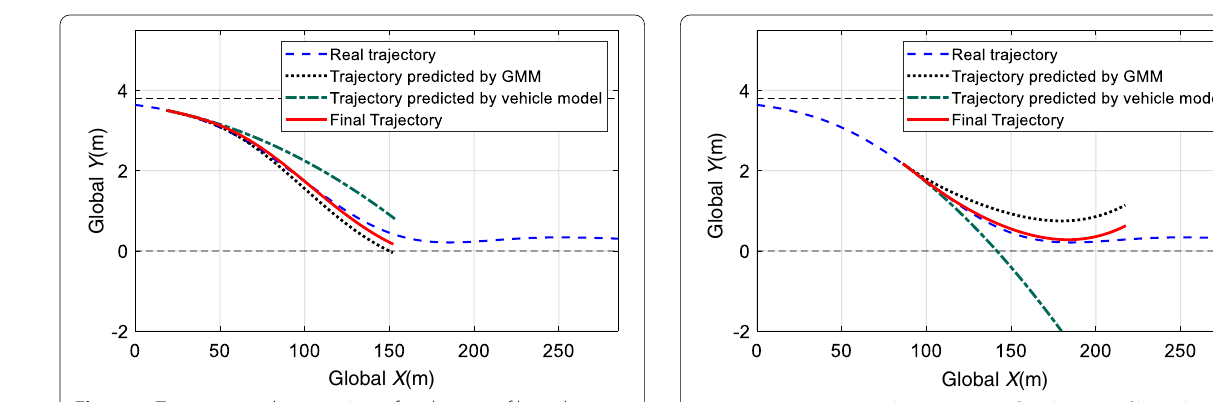
Figure 7 Trajectory prediction at 2.4 s after the start of lane